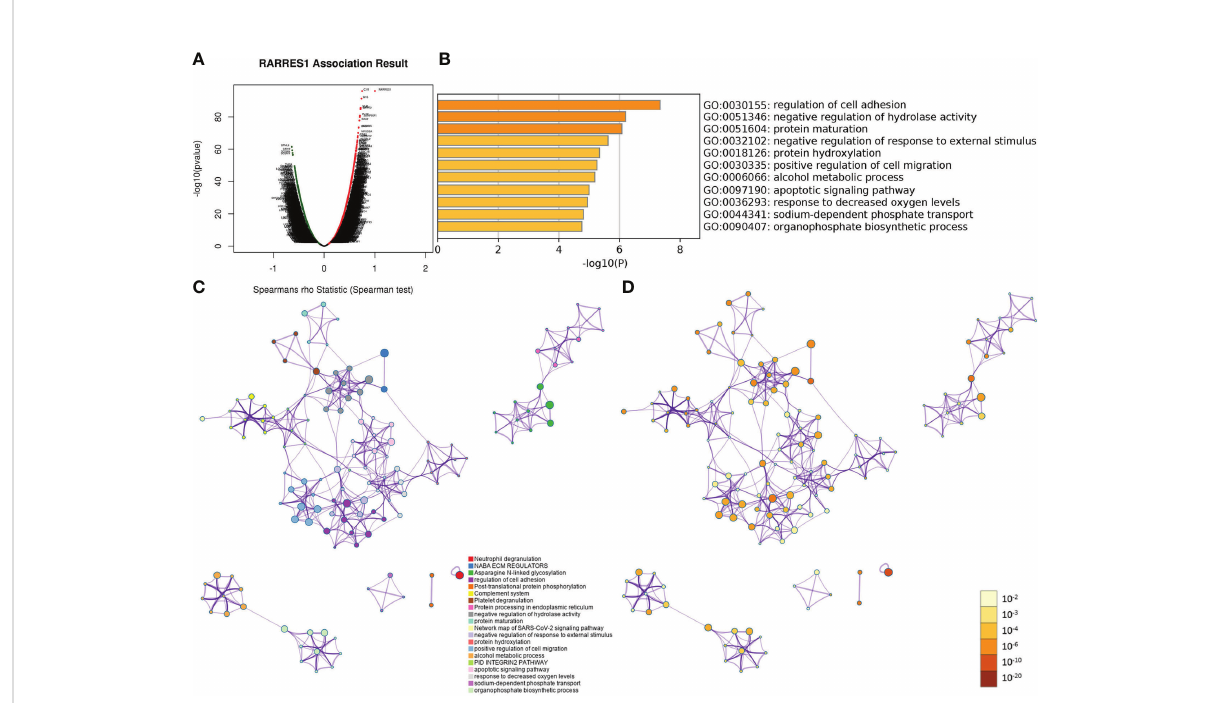
FIGURE 2 GO and PPI analyses of RARRES1-correlated genes. (A) The genes highly correlated with RARRES1 identi fi ed by Pearson correlation analysis in the KIRC cohort. (B) Main GO biological processes of all 284 genes correlated with RARRES1. (C) The PPI networks determined by functional cluster analysis. The different colors represent different functional clusters. (D) The PPI networks determined by functional cluster analysis. The different colors represent different P values. GO, Gene Ontology. PPI, protein – protein